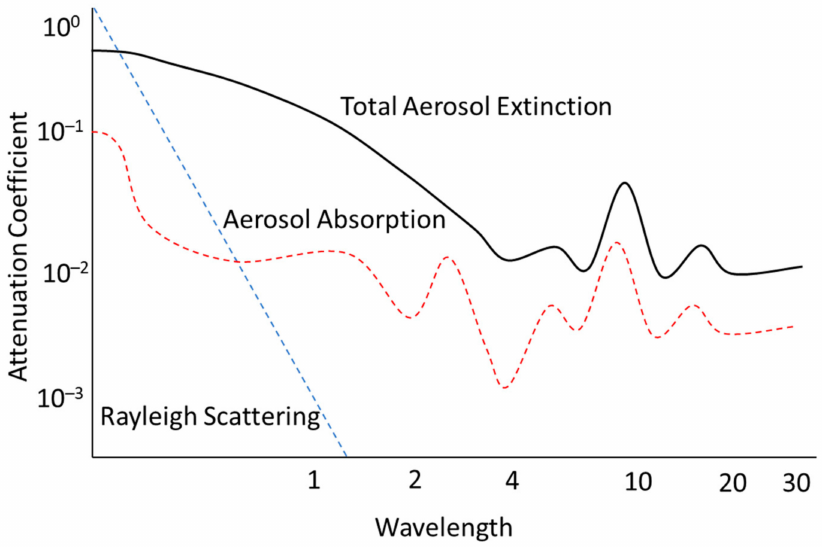
Figure 13. Atmospheric scattering and absorption coefficients. Adapted from [28,47].